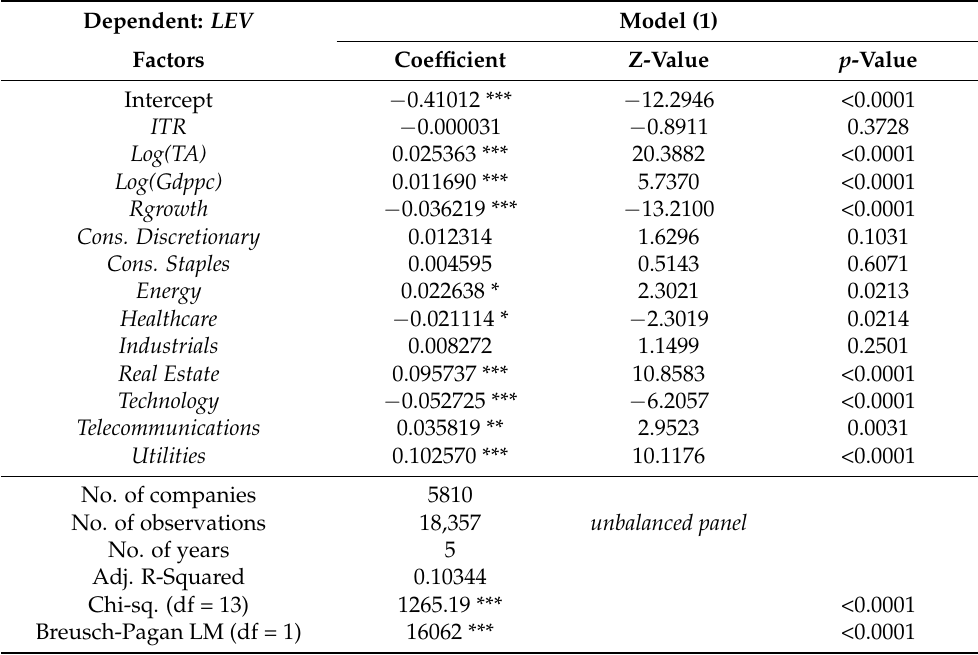
Table 6. Panel regression results for leverage ( LEV ) as the dependent variable. Dependent: